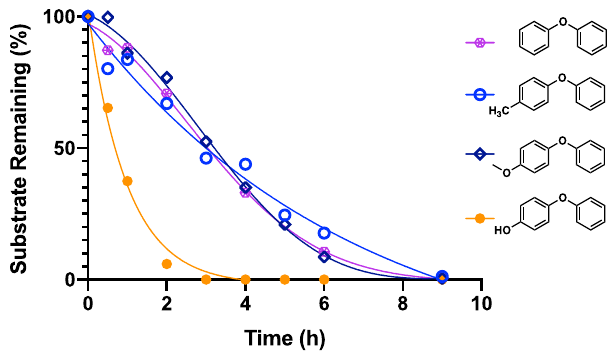
Fig. 4 Substituent effects on DAE cleavage rates. C-O ether bond cleavage rate of different electron-donating group substituted diphenyl ether under standard ECH condition. For additional time courses and product analyses see supplementary